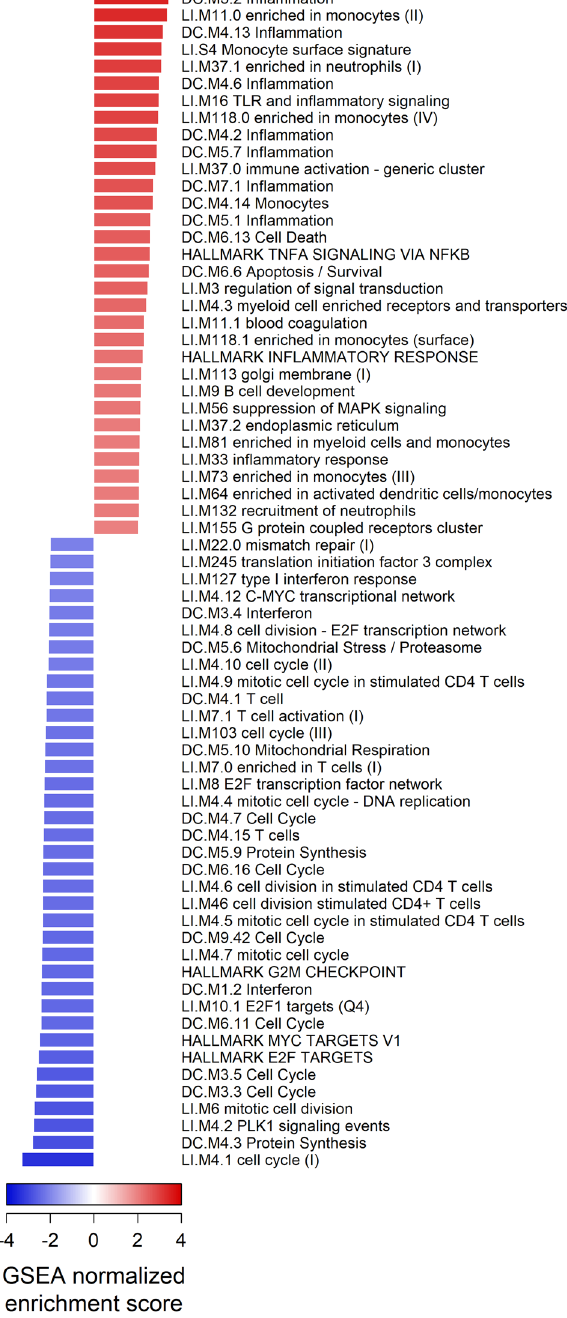
Fig. 1 GSEA results on the pooled set of preimmunization transcriptomes from four malaria vaccine trials. Gene sets with positive GSEA normalized enrichment scores indicate they are signi fi cantly enriched for genes with higher transcript abundance in protected subjects; negative scores indicate signi fi cant enrichment for genes with lower transcript abundance in protected subjects. Gene sets shown have absolute scores >2.0 and FDR-adjusted P - values <0.05. Sets named “ Undetermined ” or “ TBA ” are not